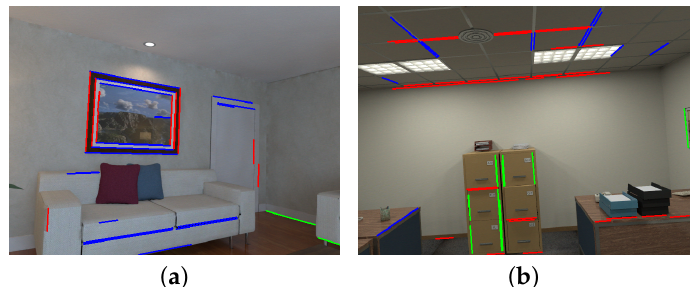
Figure 5. Results of parallel-line clustering that are used to compute vanishing directions: ( a ) the 120-th image in ‘Living Room 2’ sequence. ( b ) the 64-th image in ‘Office Room 1’ sequence. Lines with the same color are parallel in the real world. The vanishing directions obtained by these parallel lines can provide accurate and reliable constraints for MW